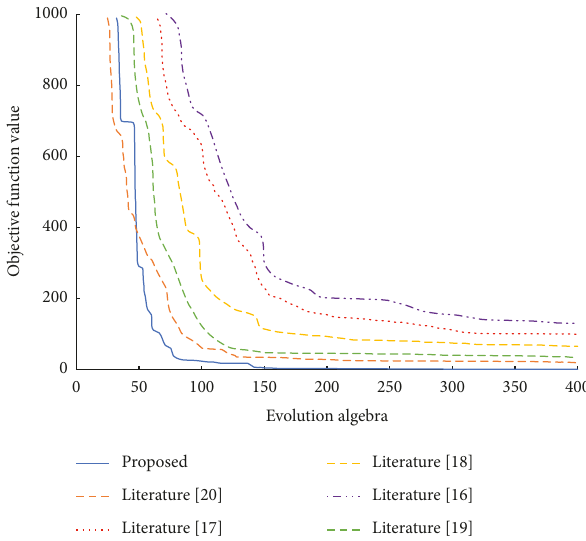
Figure 7: Comparison of algorithm convergence capability.